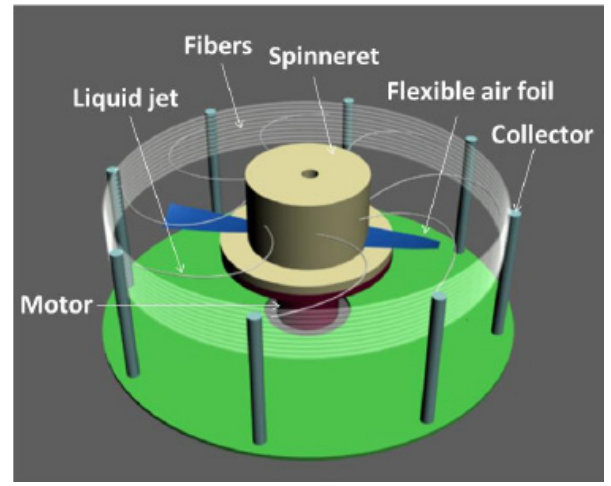
Figure 1. Structure drawing of a centrifugal spinning